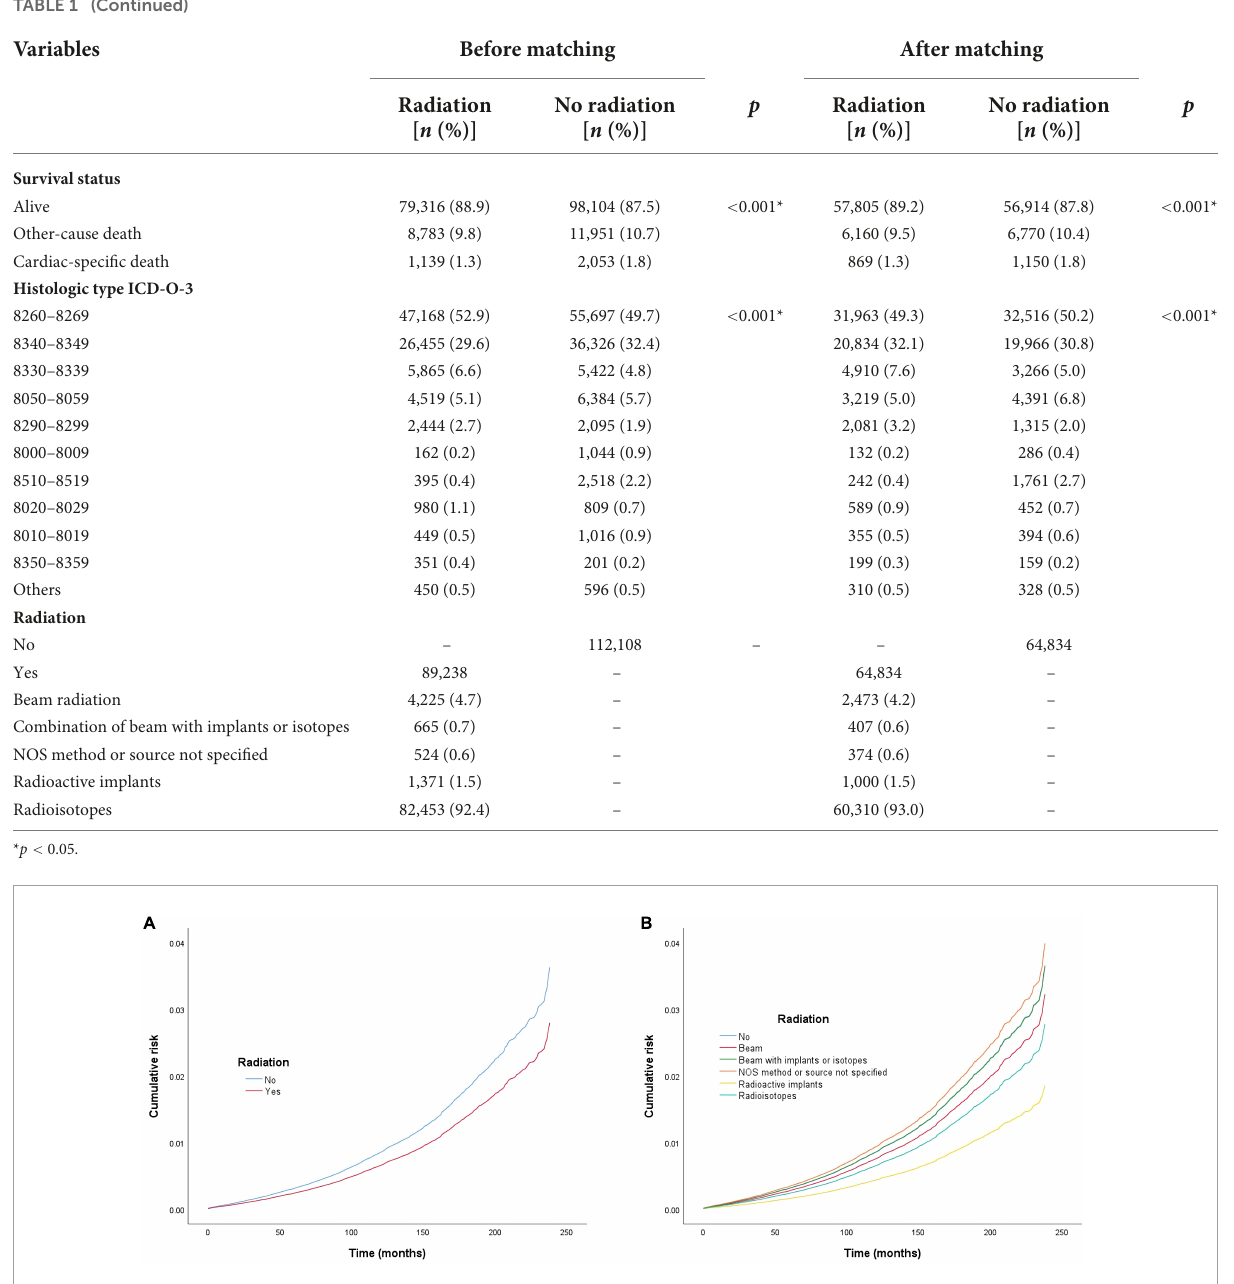
FIGURE1 Cumulative risk of cardiac-specific death related to radiation therapy (RT) before propensity score matching (PSM) (the curves of “no radiation” and “beam with implants or radioisotopes” are overlapping and may not be drawn separately). The Y -axis of each panel shows the cumulative risk of cardiac-specific death and the X -axis shows the time since diagnosis in months. Each line represents the cumulative risk of cardiac-specific death in patients after receiving a treatment. (A) Cumulative risk of cardiac-specific death in patients with receiving and not receiving radiotherapy. (B) Cumulative risk of cardiacspecific death in patients with not receiving radiotherapy and receiving different modalities of radiotherapy.